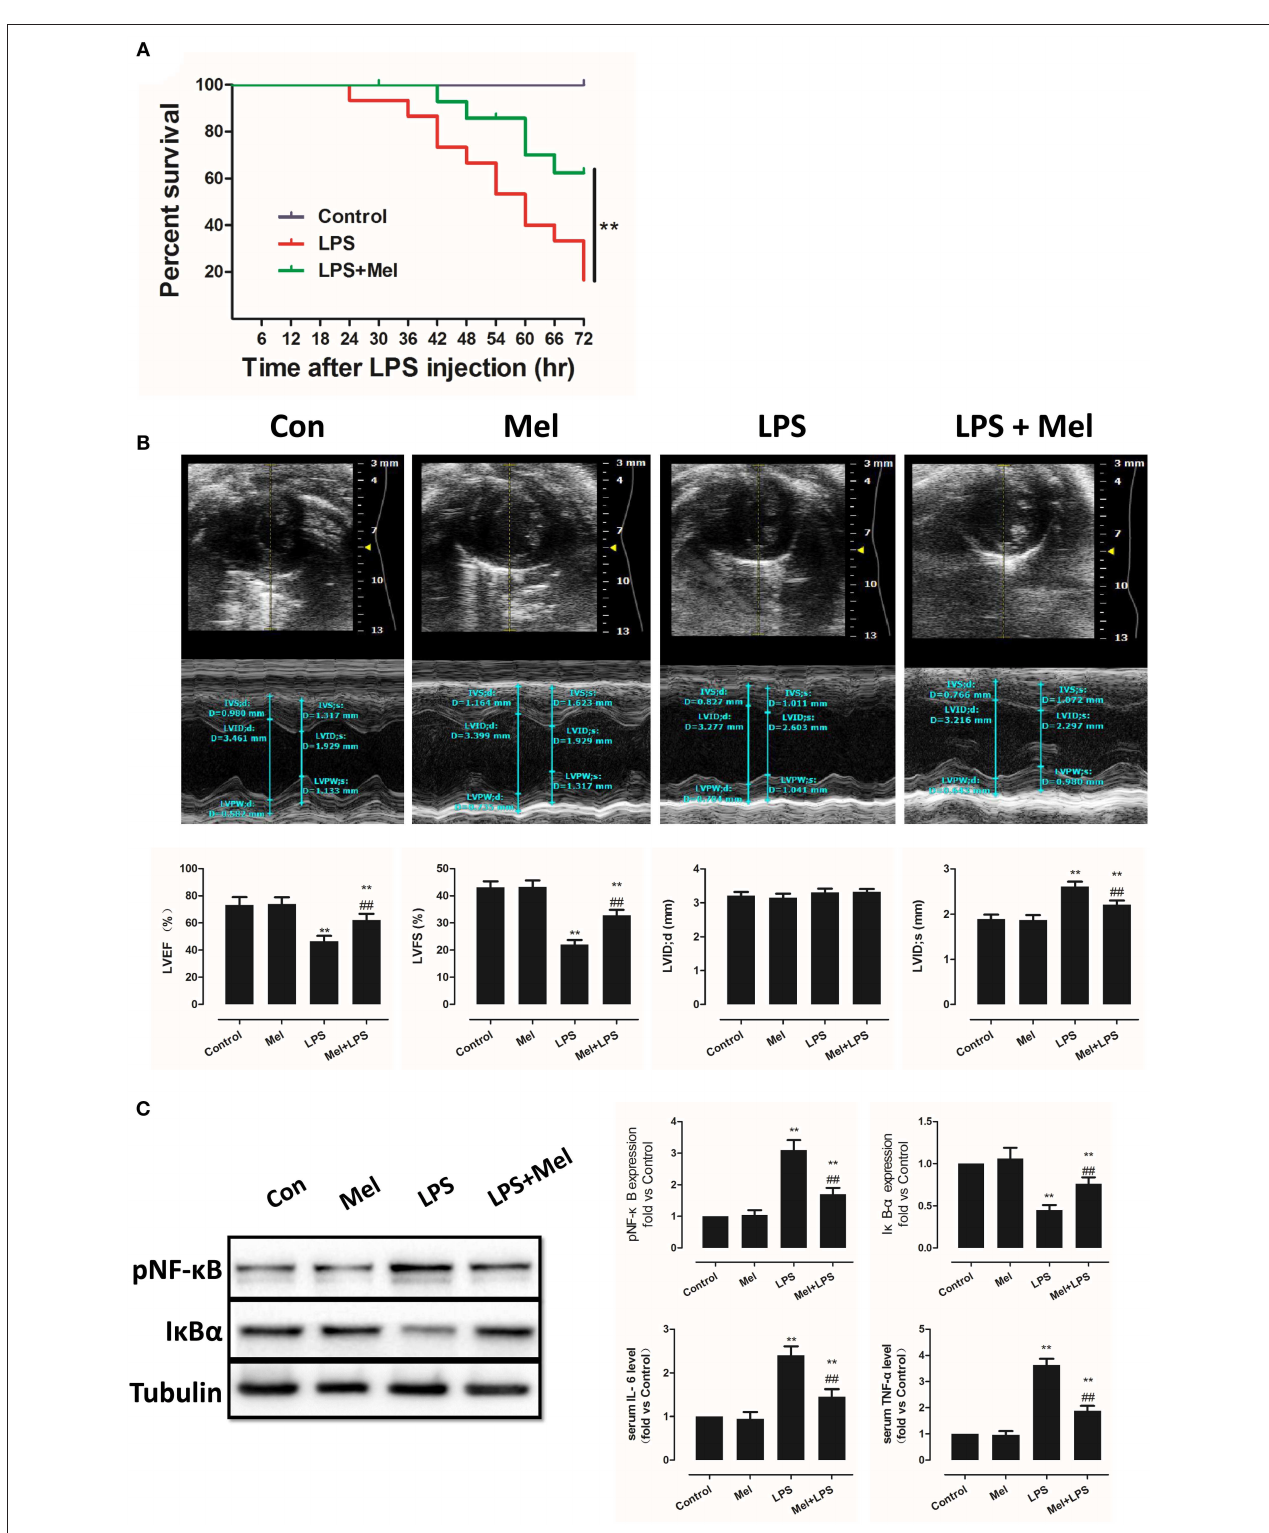
FIGURE 1 | Effects of melatonin administration on survival, cardiac dysfunction and inflammation after LPS insult. (A) 30 mg/kg LPS was given to mice to assess the effects of LPS on survival rate. The mice survival rate was evaluated using Kaplan-Meier curves ( n = 15). (B) Representative M-mode echocardiograms from mice in each group and quantitative analysis of the LVEF, FS, LVID; d, LVID; s. (C) Representative bands of pNF- κ B, I κ B α and Tubulin, quantitative analysis of pNF- κ B, I κ B α expression and serum IL-6, TNF- α levels. n = 6 ** P < 0.05 vs. the control group, ## P < 0.05 vs. the LPS group. Mel, melatonin.